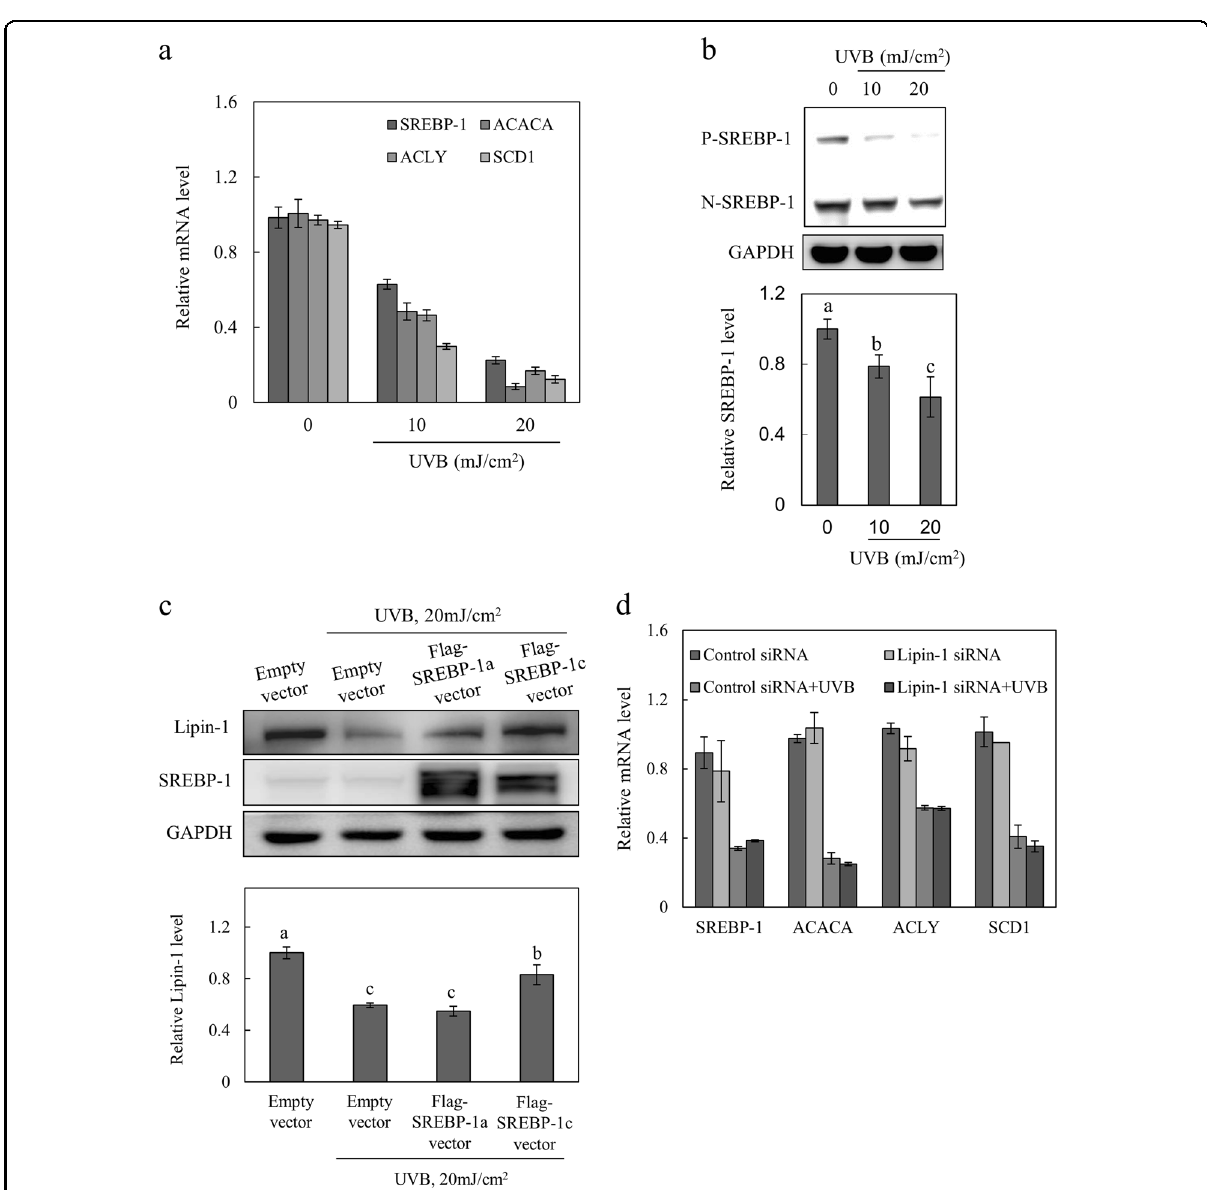
Fig. 2 UVB-induced lipin-1 inhibition is mediated through SREBP-1 downregulation. NHEKs were treated with different doses of UVB (0, 10, and 20 mJ/cm 2 ) and cultured for 24 h. a Total RNA was extracted from cells, and the relative mRNA levels of SREBP-1 and SREBP-1 target genes (ACACA, ACLY, and SCD1) were measured via qRT-PCR. b Cell lysates were immunoblotted to determine precursor (P) and nuclear (N) forms of SREBP-1. Protein levels of SREBP-1 were normalized to GAPDH. c NHEKs transfected overnight with the vector containing Flag-SREBP-1a, Flag-SREBP-1c cDNA, or empty pcDNA3.1 vector were exposed to 20 mJ/cm 2 UVB radiation and cultured for 24 h. The protein levels of lipin-1 were normalized to GAPDH. All data (mean ± SD) represent three independent experiments. Means without a common letter differ; P <